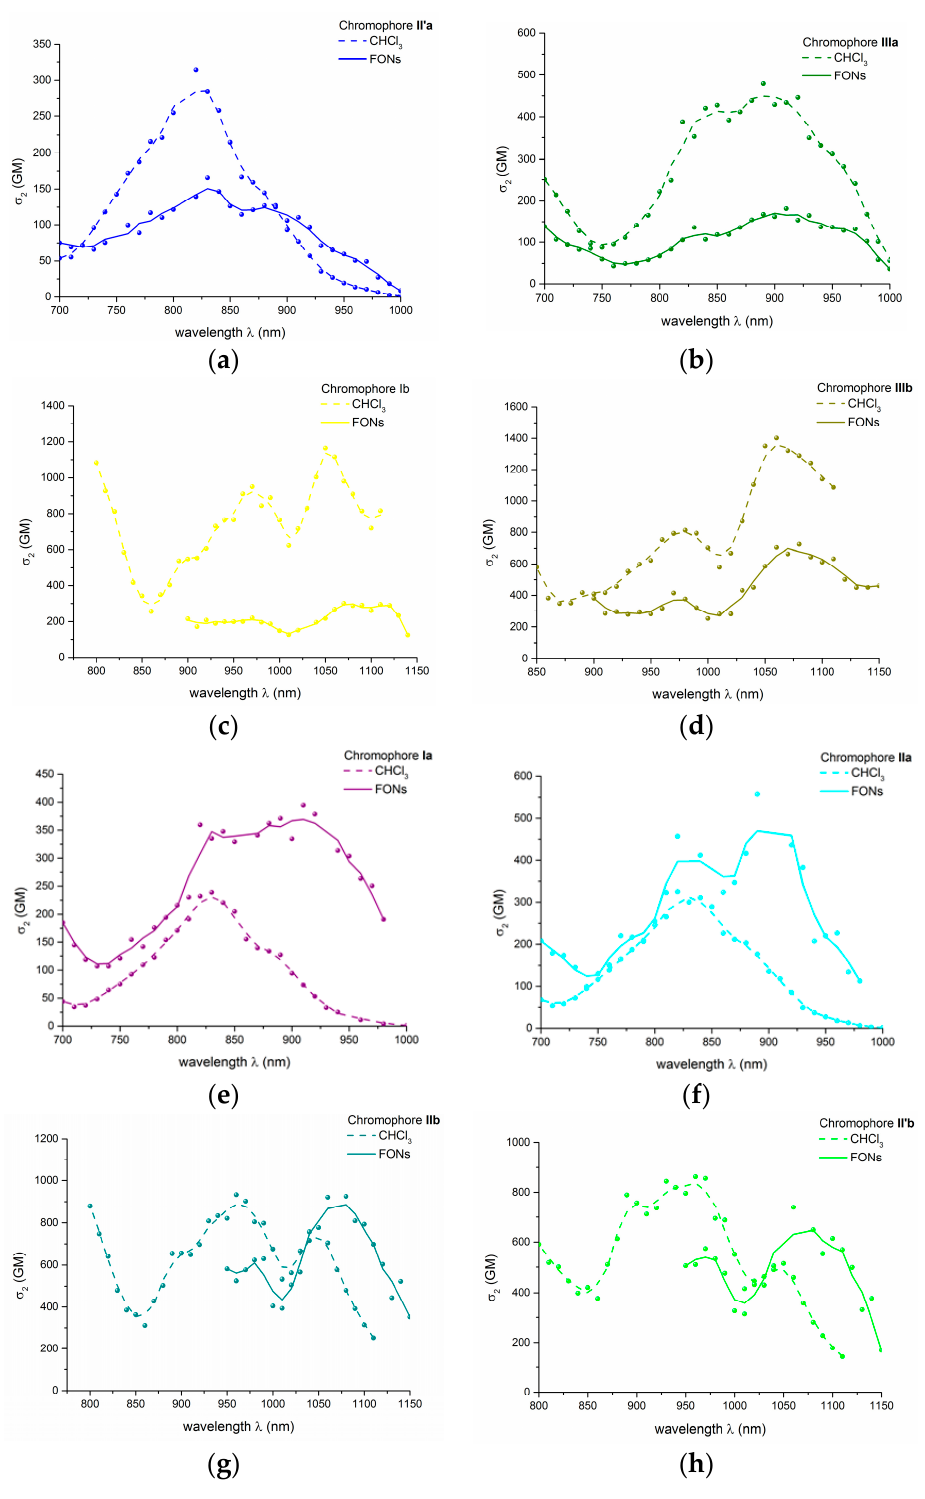
Figure 5. Comparison of the 2PA spectra of the dye dissolved in CHCl 3 and as subunits of FONs in water: ( a ) II’a ; ( b ) IIIa ; ( c ) Ib ; ( d ) IIIb ; ( e ) Ia ; ( f ) IIa ; ( g ) IIb ; ( h ) II’b .